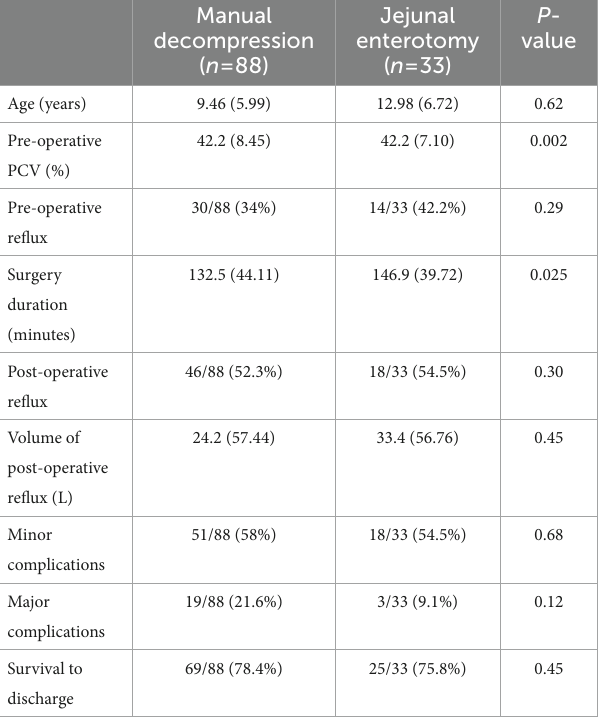
TABLE 2 Dependent and independent variables evaluated for each surgical treatment group. Manual